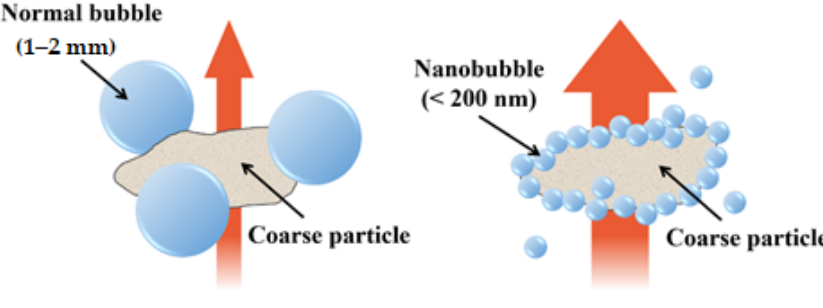
Figure 9. Effect of nanobubble size on a cement particle’s flotation [36].